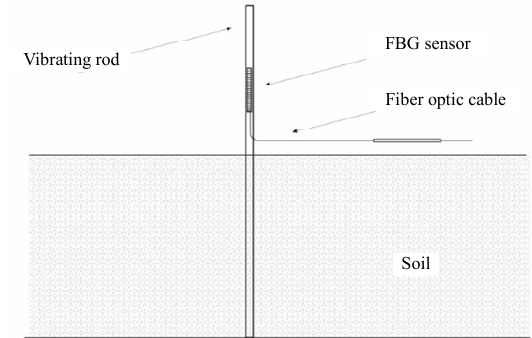
Fig. 1 Vibration sensor structure.